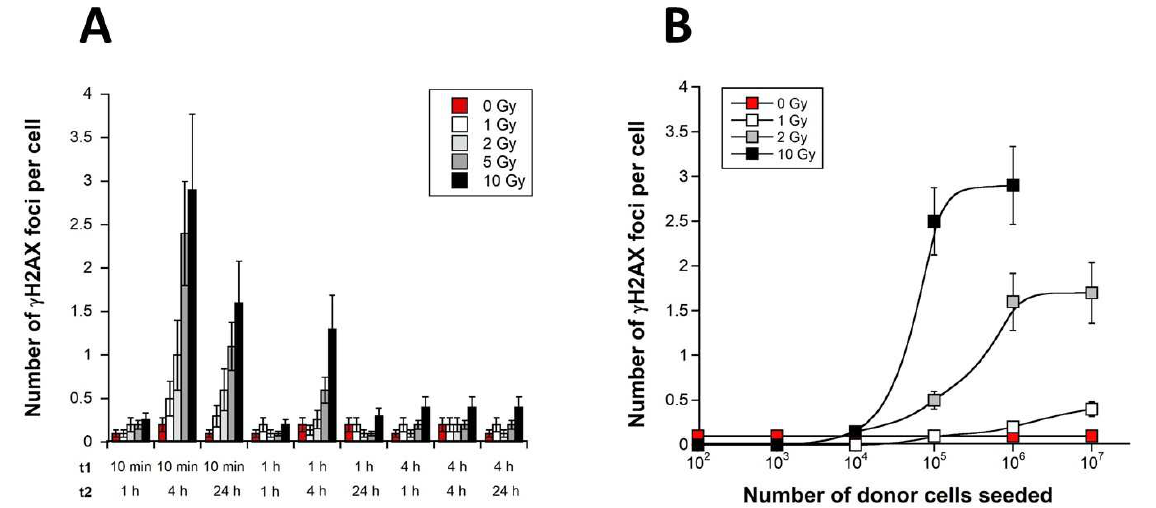
Figure 1. Characterization of the RIBE induced by a medium transfer approach with 50 keV syn- chrotron X-rays. ( A ) One million confluent 1BR3 donor fibroblasts were irradiated at the indicated doses with monochromatic 50 keV synchrotron X-rays in DMEM medium that was kept in the pres- ence of donor cells for t1 post-irradiation (10 min–4 h), and then applied to unirradiated autologous receptor cells for t2 (1–24 h). The number of γ H2AX foci per cell was plotted as a function of the t1 and t2 values. Each γ H2AX data value represents the mean ± standard error of the mean (SEM) of three independent replicates. ( B ) By applying the same methodology, the number of γ H2AX foci per cell was plotted against the number of donor cells irradiated at the indicated doses. Each γ H2AX data value represents the mean ± SEM of three independent replicates. Data were fitted to a sigmoidal